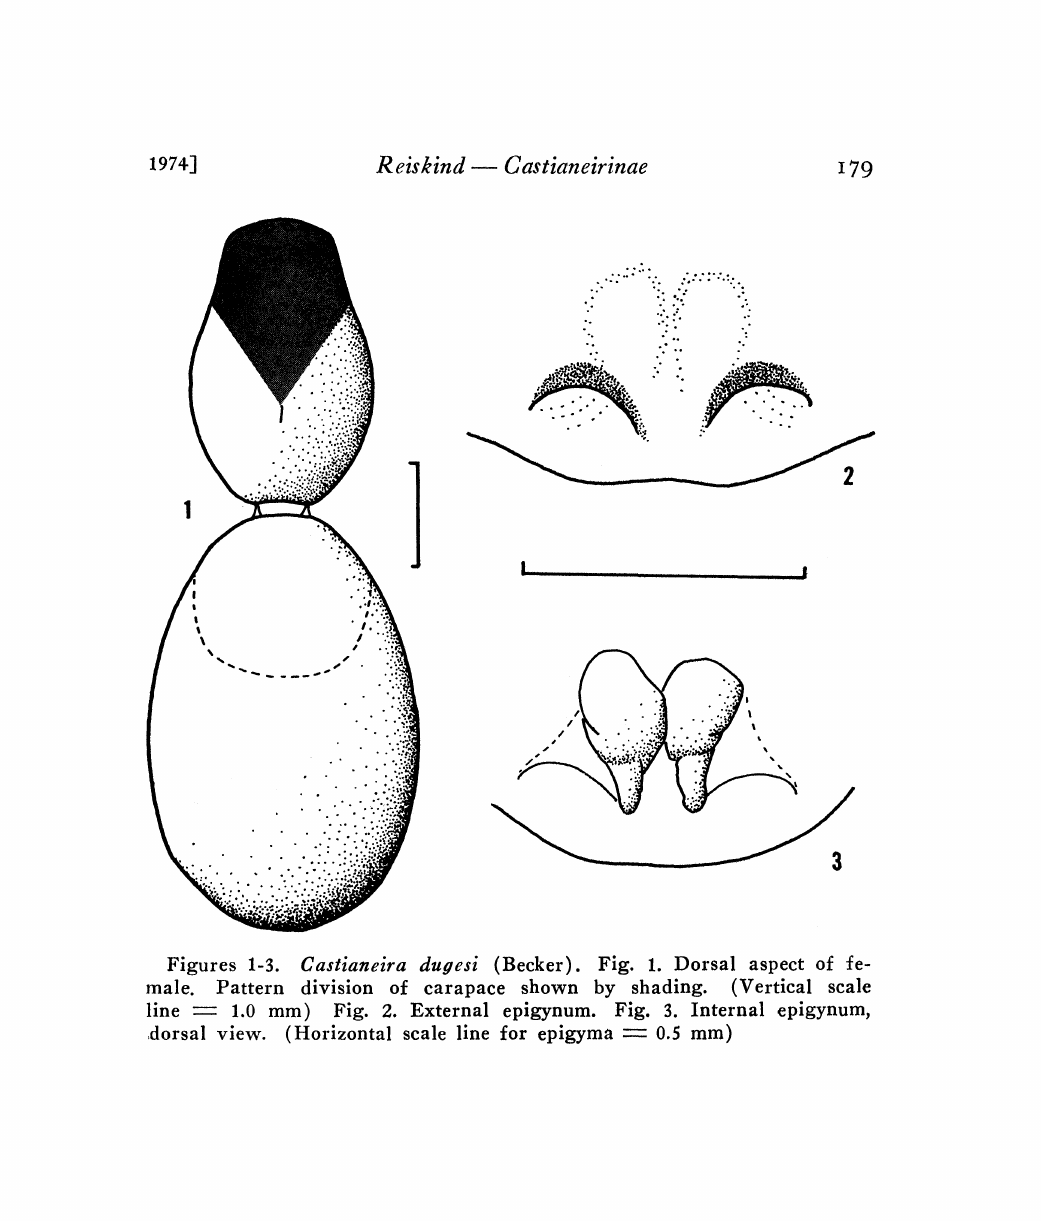
Figures 1-3. Castianeira dugesi (Becker). Fig. 1. Dorsal aspect of fe- male. Pattern division of carapace shown by shading. (Vertical scale line 1.0 mm) Fig. 2. External epigynum. Fig. 3. Internal epigynum, dorsal view. (Horizontal scale line for epigyma 0.5